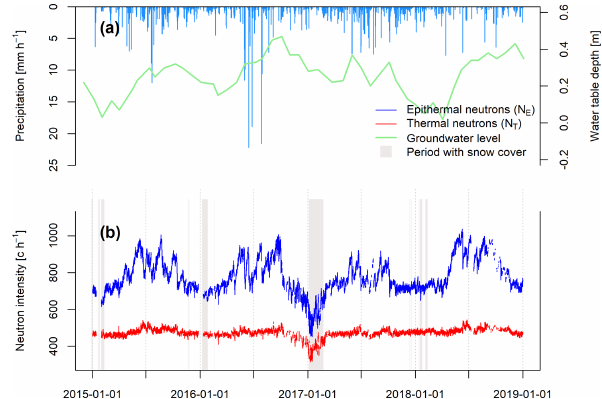
Figure 2. Field observations for the period from January 2015 to December 2018, showing the (a) hourly rainfall and approximate monthly groundwater table depth in far-field peatland soils and (b) the corrected neutron intensities in the thermal ( N T ) and ep- ithermal energy range ( N E ) (b)